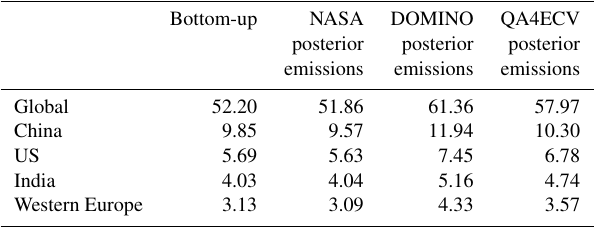
Table 1. Total NO x emission (anthropogenic plus natural) budgets in 2010 (TgNyr − 1